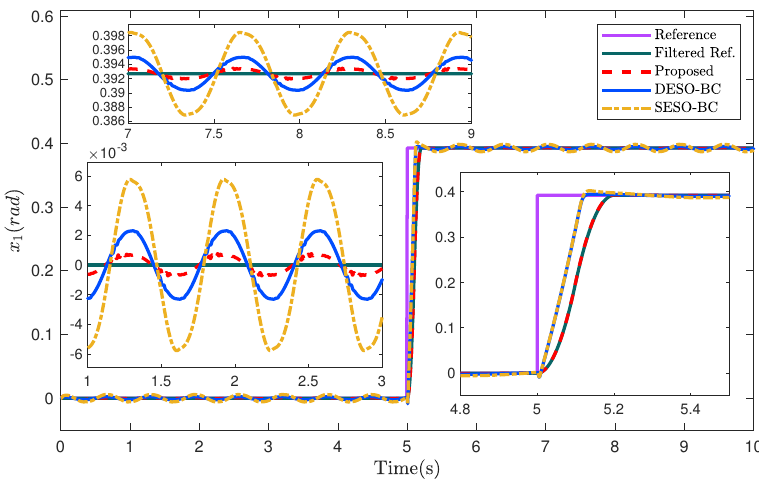
Figure 5. Tracking performances of all controllers in case of step reference trajectory.